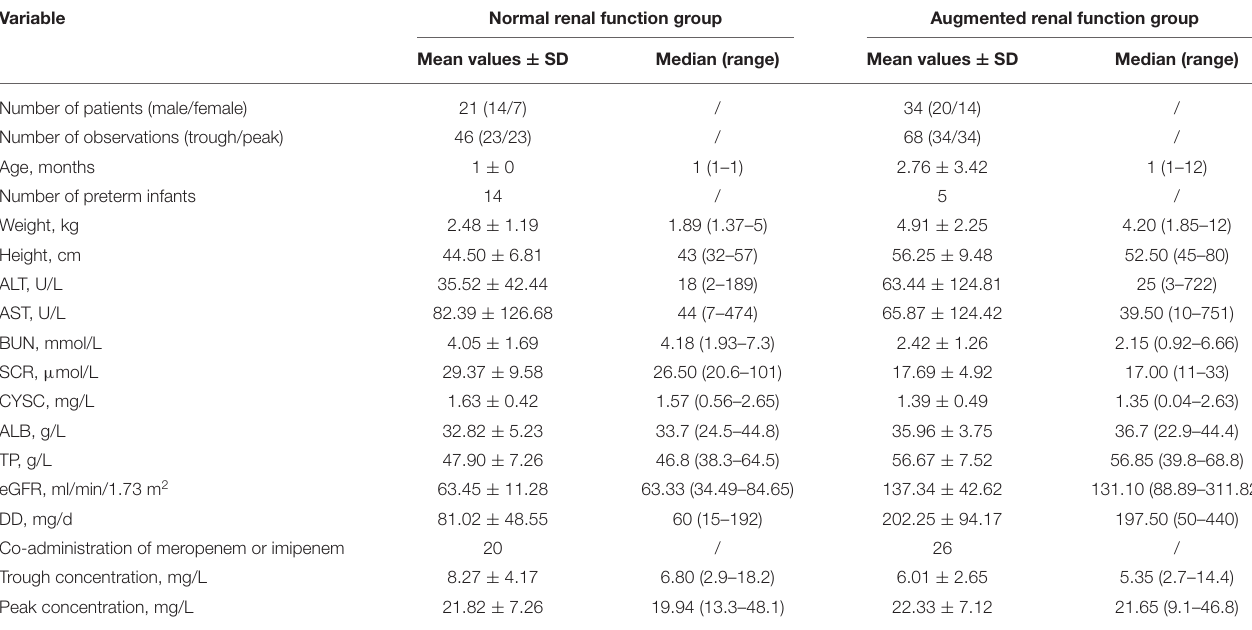
TABLE 3 | Demographic, laboratory, and clinical data of the external validation groups. Variable Normal renal function